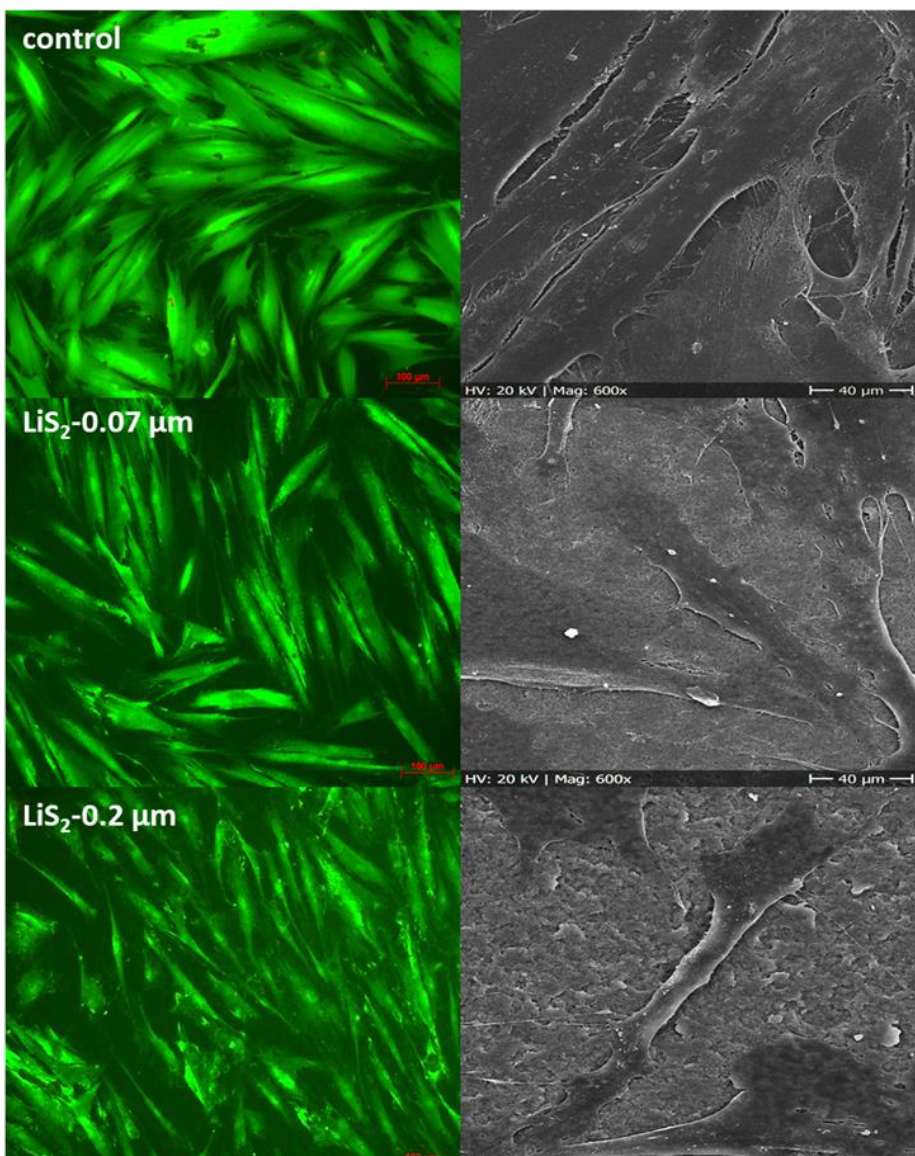
Figure 3. HGF-1 cells growing on lithium disilicate and on a control membrane (ThinCert™) at day 1 (left site = living/dead staining, magnification factor ×100, size bare 100 µm; right site = SEM, magnification factor ×600, size bare 40 µm).